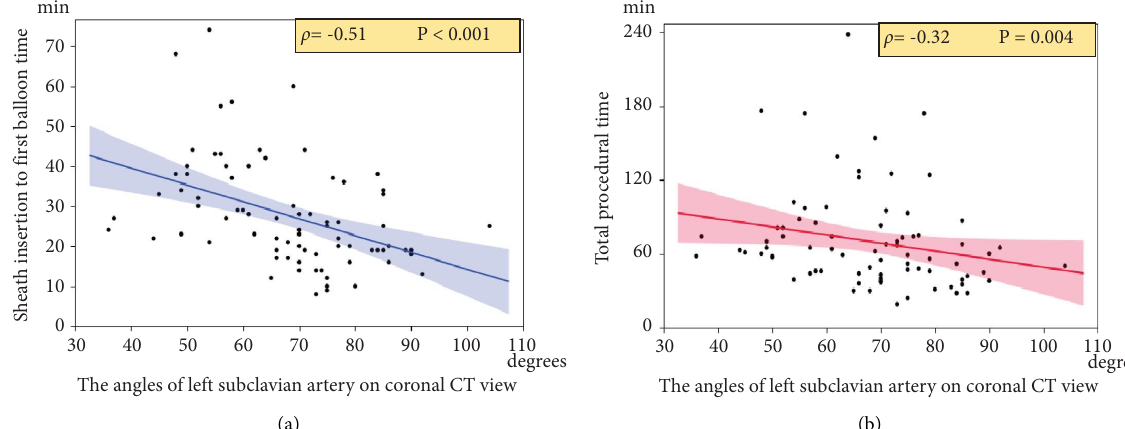
Figure 4: Correlations between the angle of the left subclavian artery in the coronal view and sheath insertion to the frst balloon time (a) and total procedural time. (b) Te details are shown in the text.